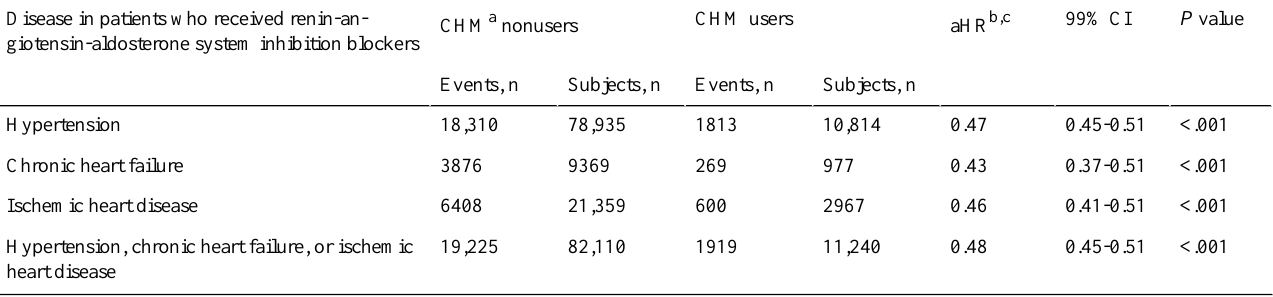
Table 4. Risks of mortality among Chinese herbal medicine users with chronic heart failure, hypertension, and ischemic heart disease under renin-angiotensin-aldosterone system inhibition